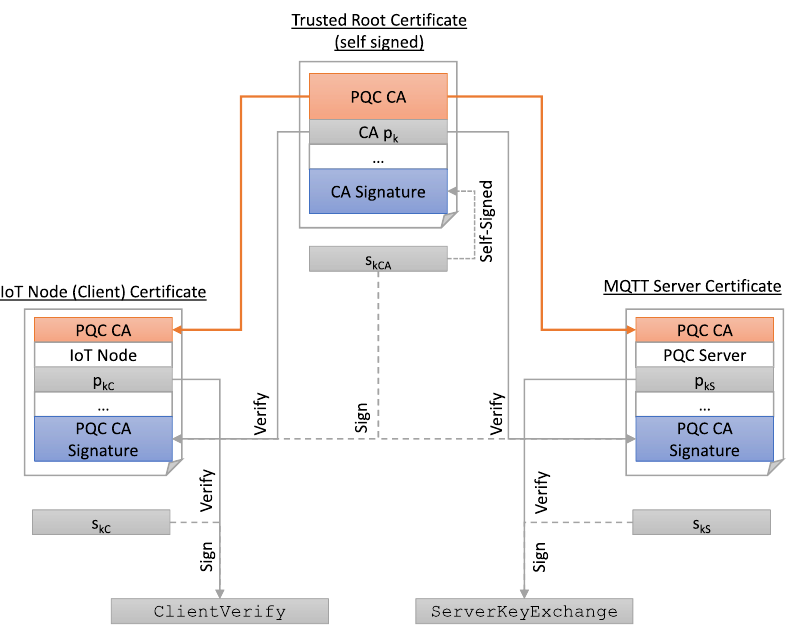
Figure 6. PKI that is used in the measurement setup.